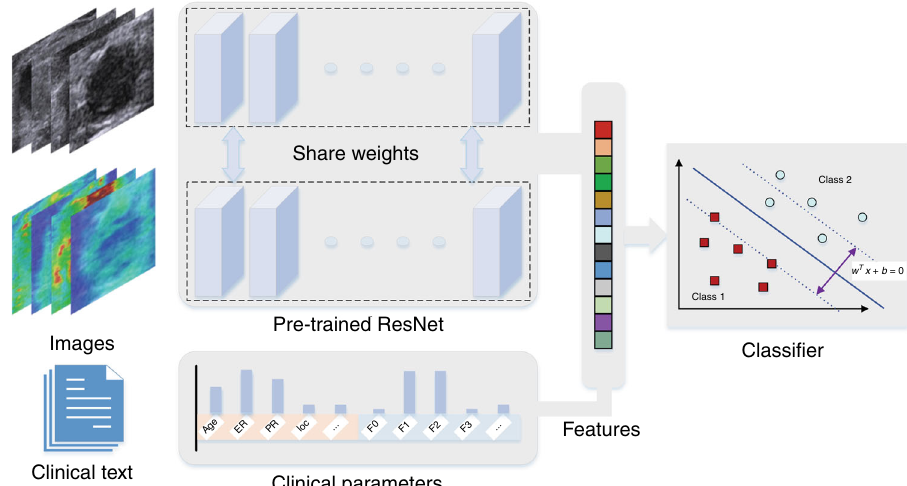
Fig. 6 The overall pipeline of the model. The parallel pre-trained ResNet model encodes the input images to features which be combined with clinical parameters. Then the combined features be classi fi ed by an SVM